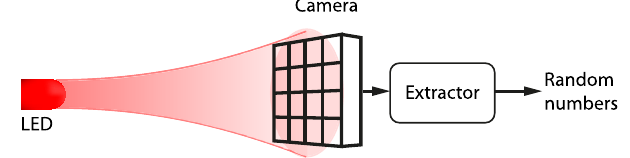
FIG. 3. Random number generator setup. A camera is fully and homogeneously illuminated by a LED. The raw binary repre- sentation of pixel values is concatenated and passed through a randomness extractor. This extractor outputs quantum random numbers.